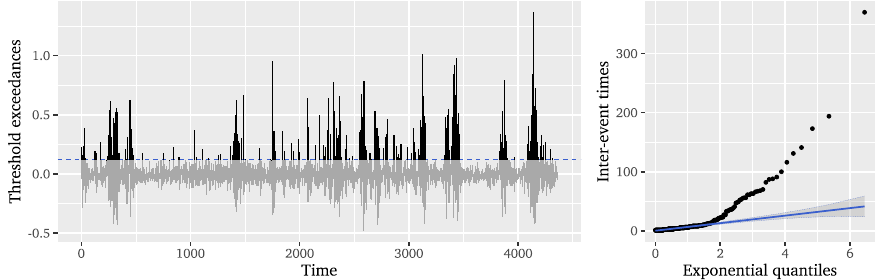
Figure 11. Exceedances for ARFIMA ( 4,0.1398,4 ) residuals with threshold u = 0.12 and QQ plot of the inter-event times.